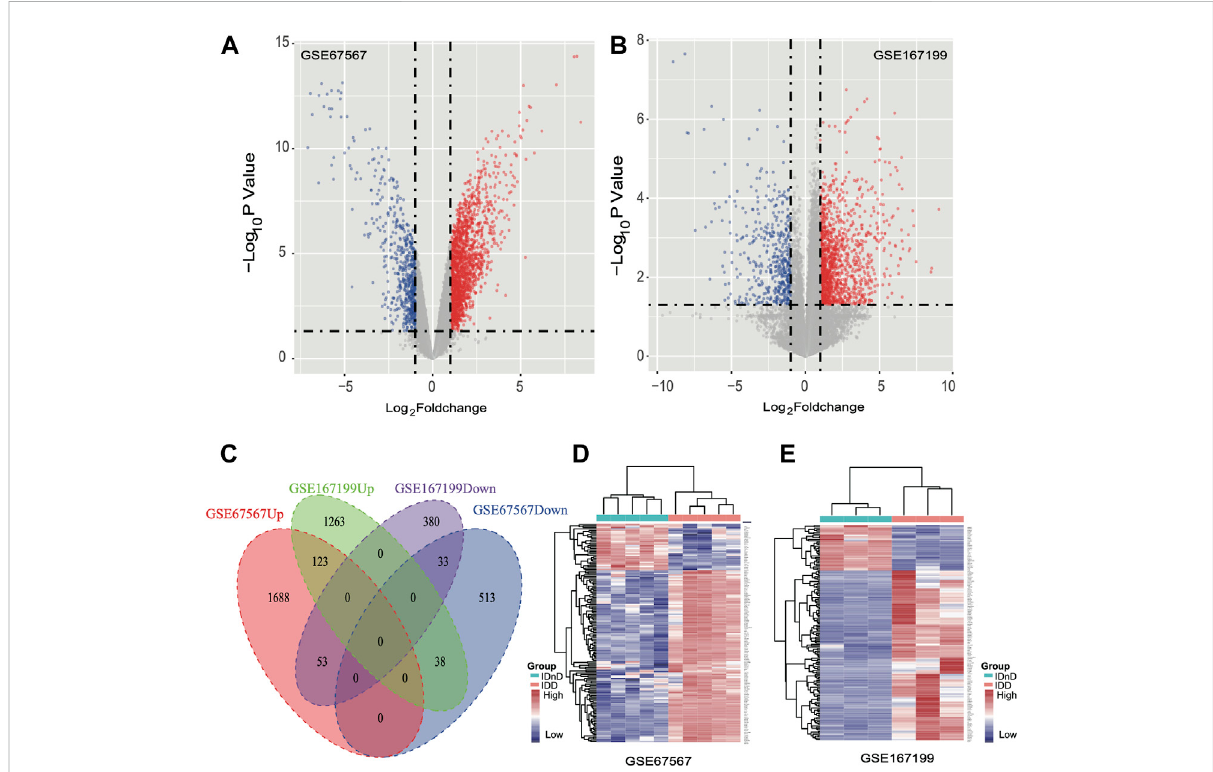
FIGURE 2 DifferentiallyexpressedmRNAsbetweenIDDandIDnD. (A) ComparisonofdifferentialmRNAvolcanoplotsbetweennucleuspulposussamples from IDD and IDnD in the GSE67567 dataset. (B) Comparison of DEG volcano plots between nucleus pulposus samples from IDD and IDnD in the GSE167199 dataset. (C) Venn diagram of the DEGs from both datasets. (D) Expression heatmap of 156 common DEGs in the GSE67567 dataset. (E) Expression heatmap of 156 common DEGs in the GSE167199 dataset.